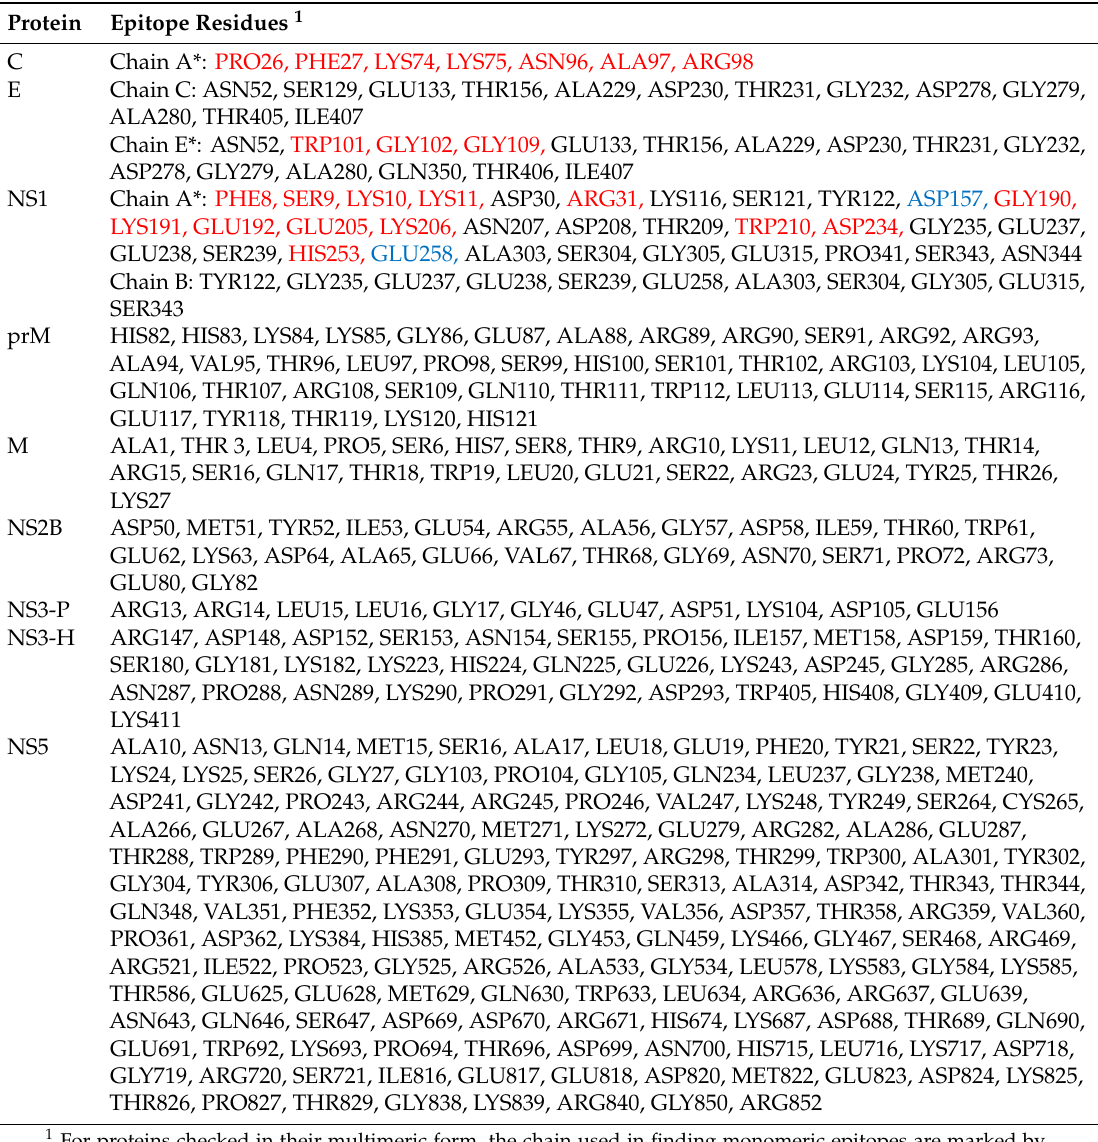
Table 8. Predicted Zika conformational